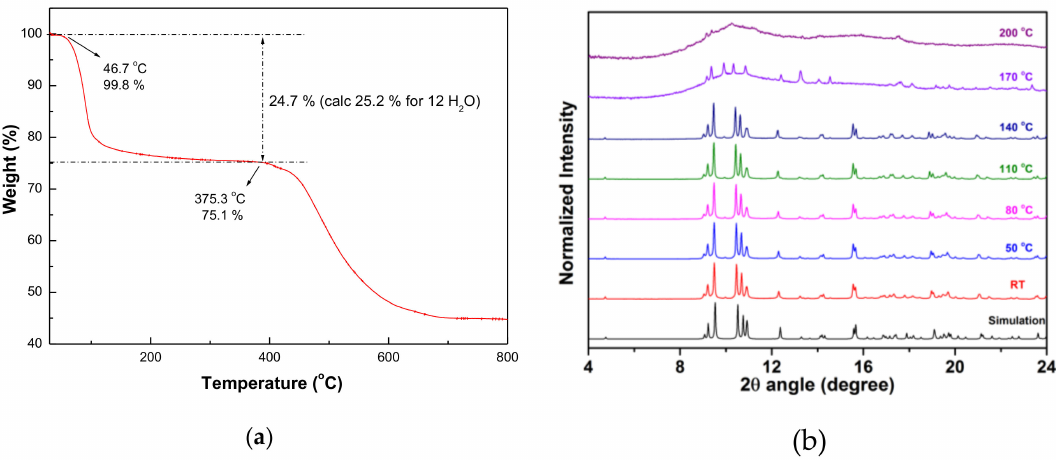
Figure 3. ( a ) Thermogravimetric analysis (TGA) and ( b ) in-situ temperature dependent powder X-ray di ff raction (XRD) measurements of 1